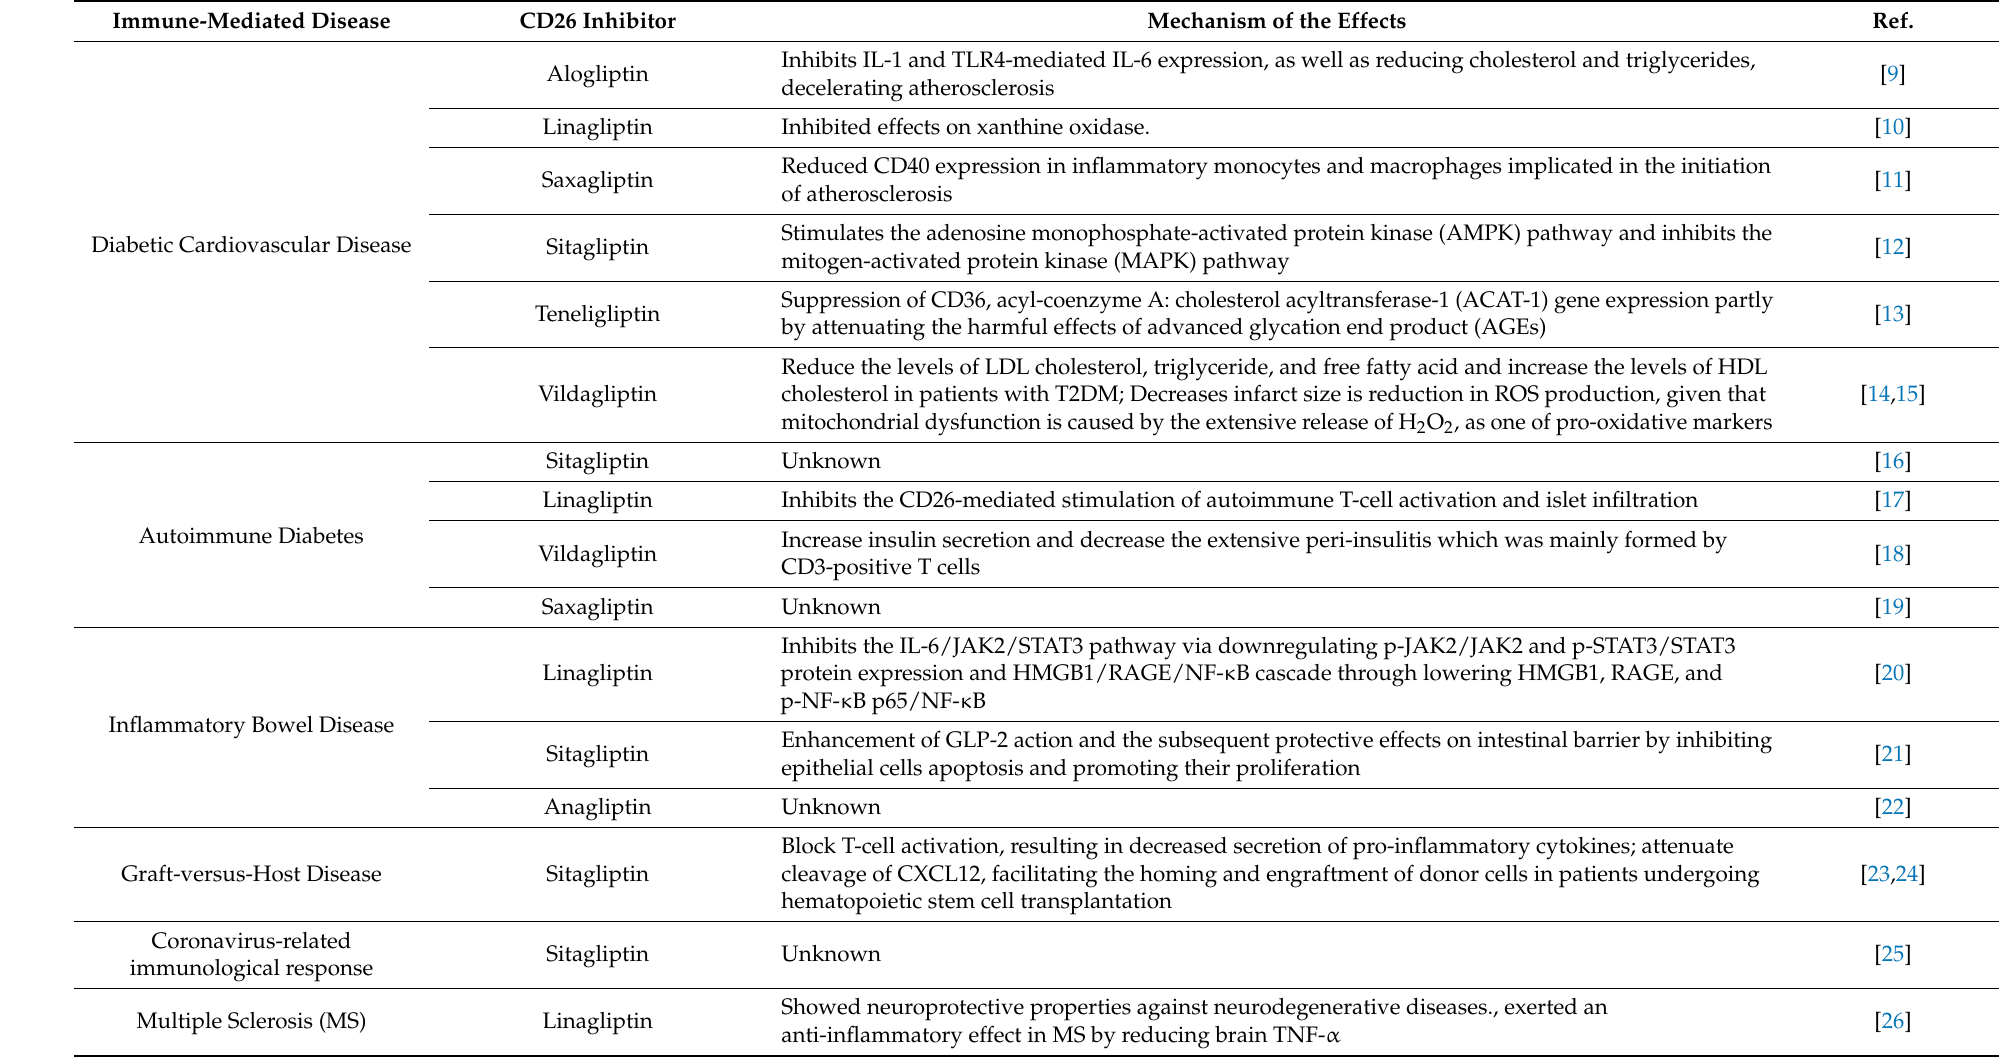
Table 1. The immunoregulation effects of CD26